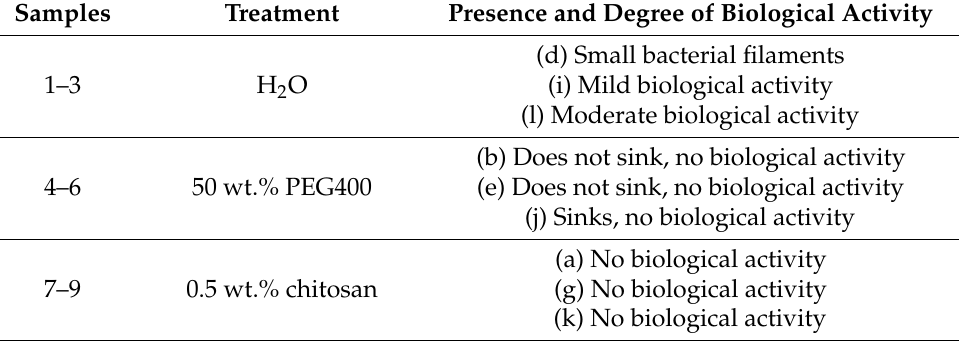
Table A1. Table of the biological activity observed in the samples during treatment relative to the treatment solutions used; numbering is related to samples seen in Figure